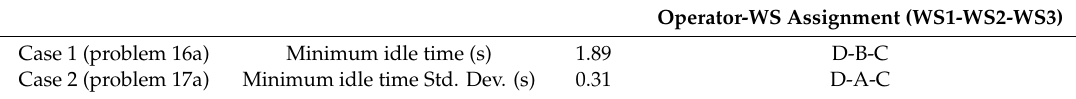
Table 11. Operator–WS assignments for T c = 14